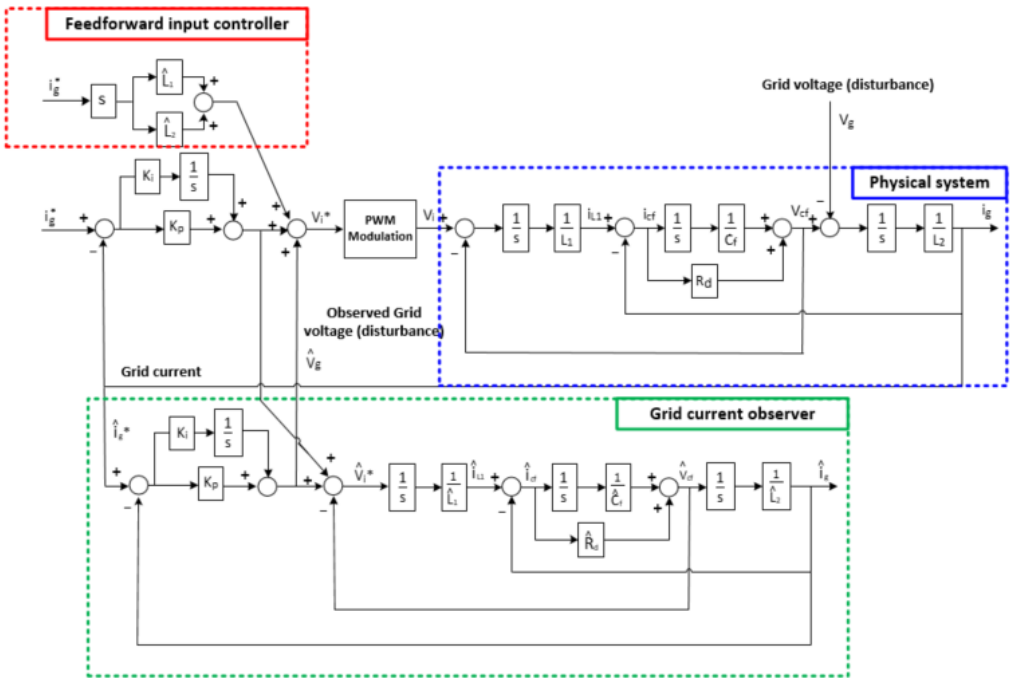
Figure 4. A system block diagram with a single-phase grid current observer for disturbance rejection in a single-phase GCI current control system.